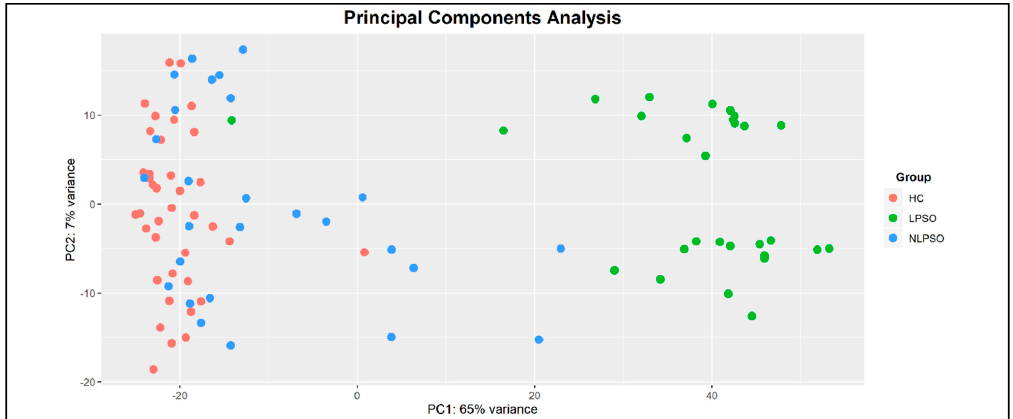
Figure 1. Principal component analysis (PCA) plot shows a substantial separation between transcriptomic profiles of psoriasis (Ps) lesional skin samples and healthy controls. Ps non-lesional skin samples showed a higher variability, although they were more similar to healthy controls compared to Ps lesional skin samples. These data have been extracted from the RNA-seq dataset published by Tsoi et al., 2019 [16]. HC: Healthy Controls; LPSO: Lesional Psoriatic Skin; NLPSO: Non-lesional Psoriatic Skin.